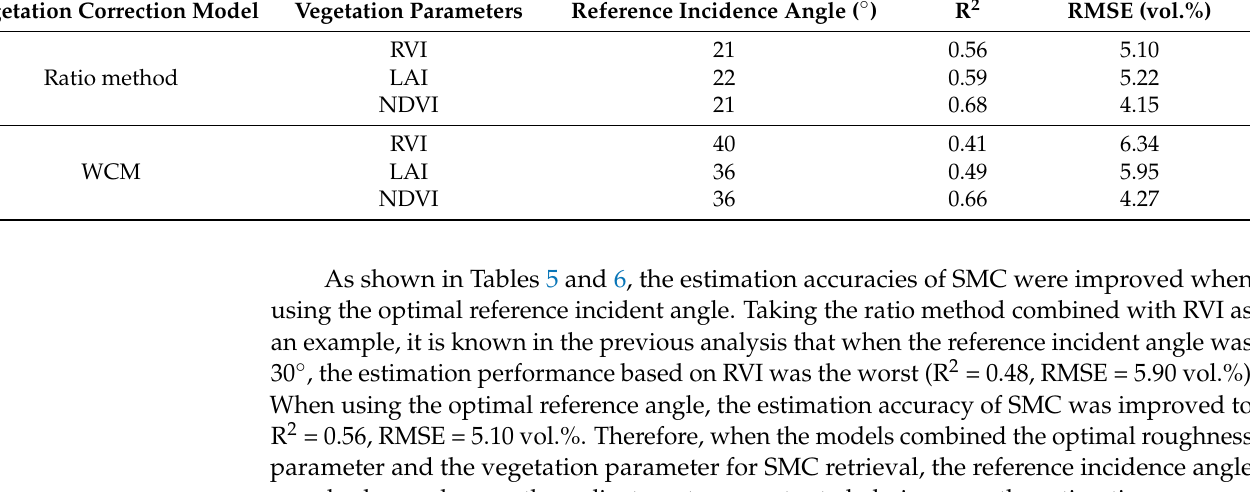
Figure 13. SMC estimation accuracy based on WCM with different reference incidence angels. ( a ) RVI; ( b ) LAI; ( c ) NDVI. Table 6. SMC estimation accuracy of validation when using the reference incidence angle. Vegetation Correction Model Vegetation